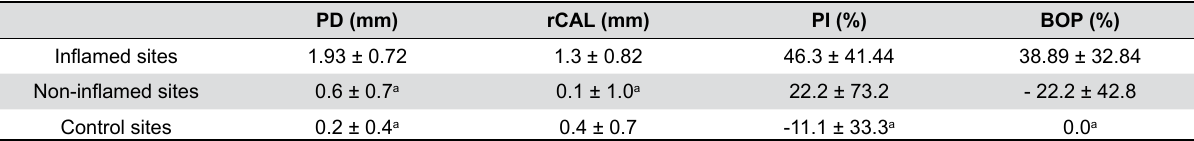
Table 2- Mean difference after periodontal therapy of inflamed, non-inflamed and control sites. Mean ± standard deviation. Kruskal-Wallis test for comparison between inflammation, non-inflammation and control sites. a: significantly lower than inflammation sites